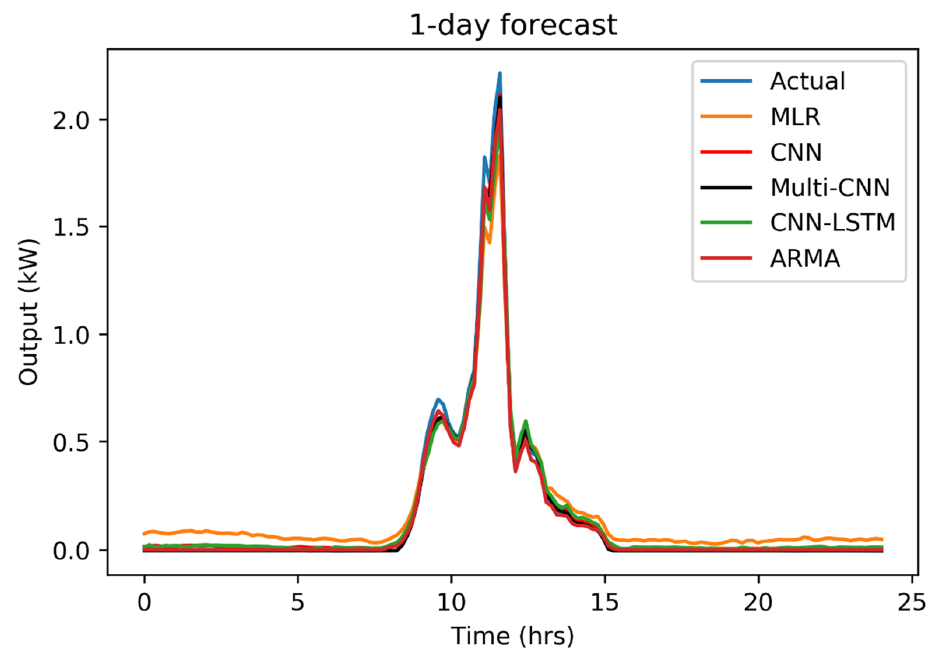
Figure 10. Comparison of different methods for the 1-day forecast (winter).